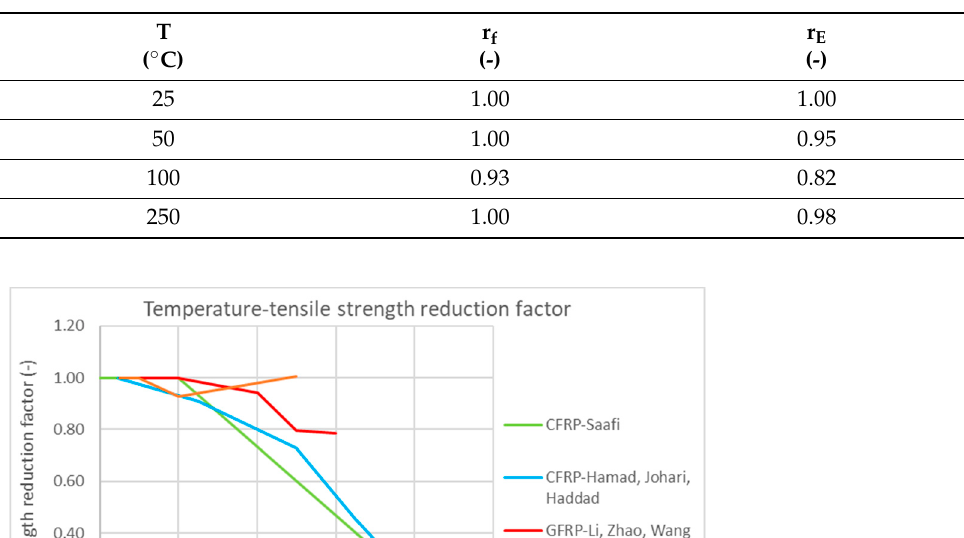
Figure 23. Temperature–elastic modulus reduction factor curves [18,23,30]. According to the results of the experiments of the present study, the modulus of elas- ticity decreases after exposure to the temperatures of 50 and 100 °C. According to Figure 23, this is in contrast to the other surveys, in which either no reduction occurs or it is much smaller. For the temperature of 250 °C, the reduction in the modulus of elasticity of the